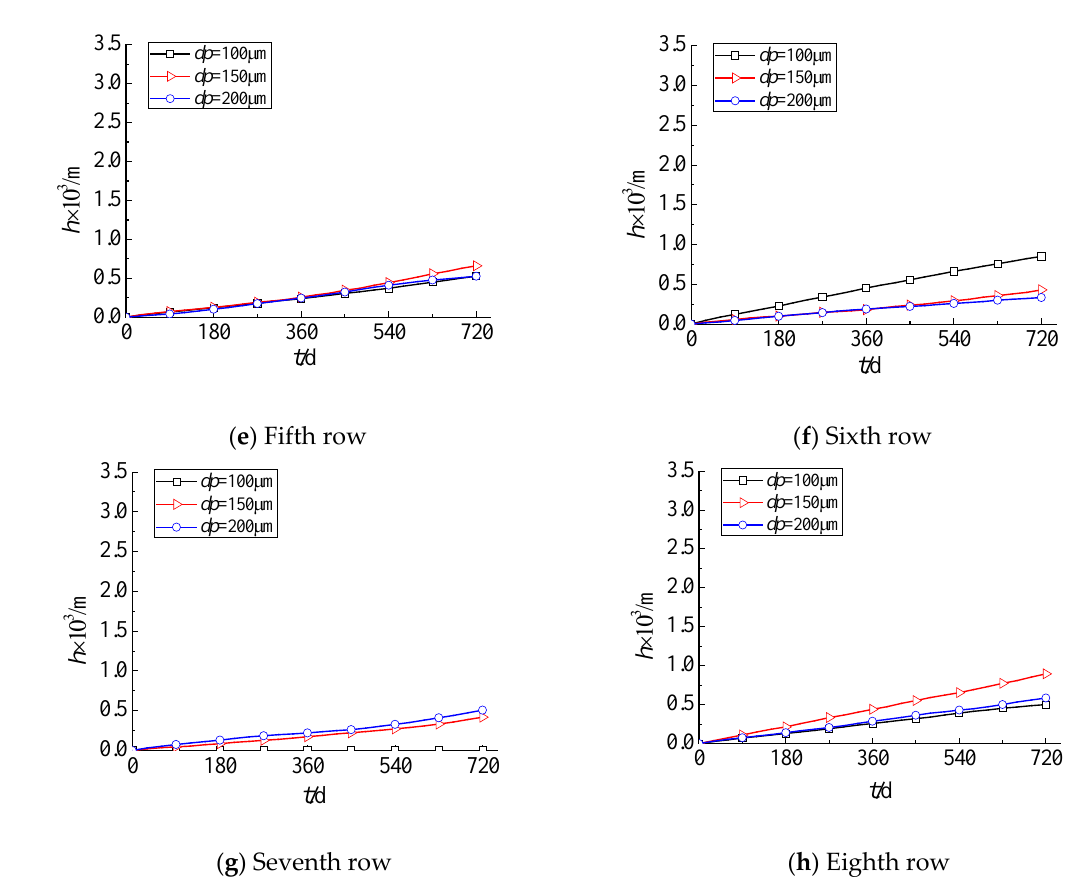
Figure 11. Maximum erosion depth under different ash sizes.